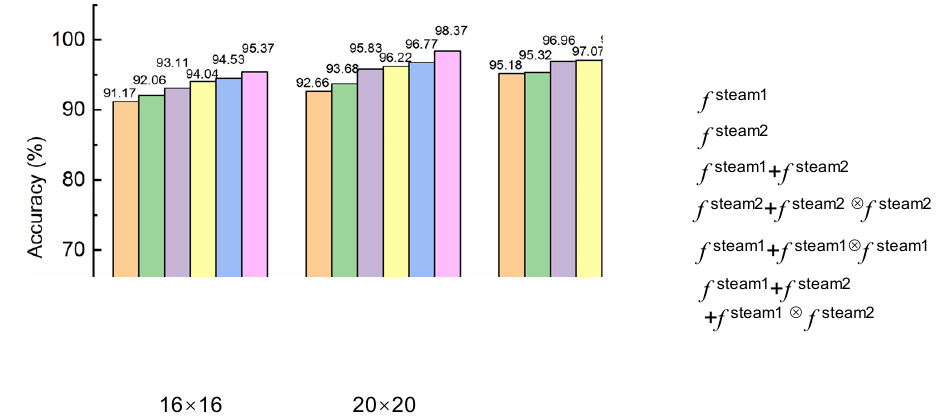
Figure 10. The contributions of cross-flow spatial interactive feature and multiorder hybrid strate- gies.